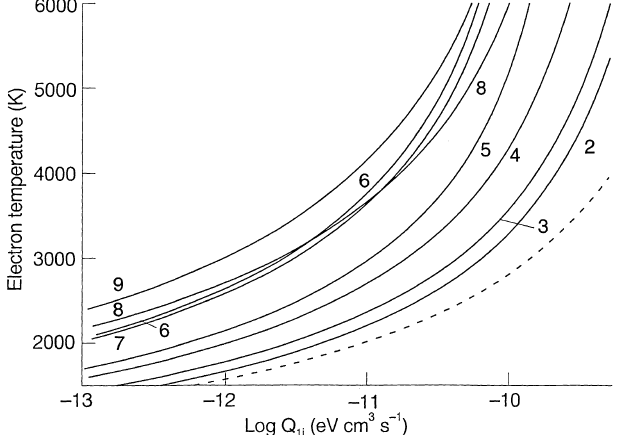
Fig. 2. The calculated Q 1 v for the N 2 vibrational levels v (cid:136) 2–9 (curves 2–9). The dashed line is the calculated value of